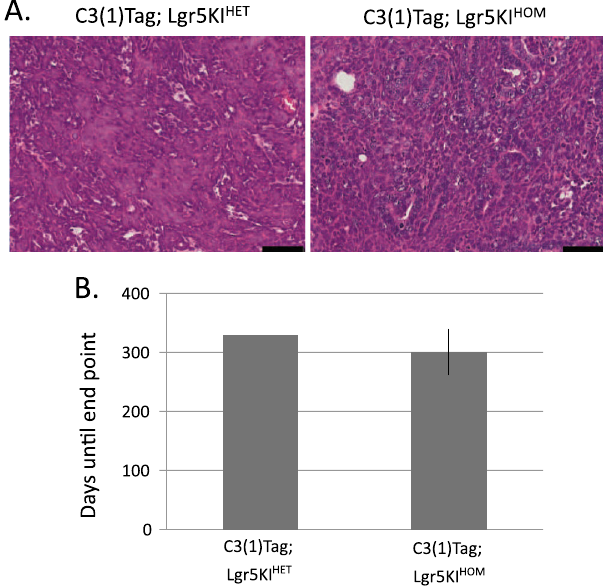
Fig. 6 Lgr5 function is not required for mammary tumorigenesis. Four thousand EpCAM HIGH ; CD49f HIGH ; GFP POS cells were harvested from Lgr5KI HET and Lgr5KI HOM ; C3(1)Tag mice at E18 and injected into cleared recipient fat pads. Mice were euthanized at end point, which was when tumors reached 1 cm in diameter. a H and E stained sections of tumors harvested from mice transplanted with C3(1)Tag; Lgr5KI HET and C3(1)Tag; Lgr5KI HOM fMaSCs. Bar represents 50 µM. b Time to endpoint (tumors with a diameter of 1 cm) was compared between glands that were transplanted with Lgr5KI HOM or Lgr5KI HET ; C3(1)Tag fMaSCs. Two mice reached end point due to Lgr5KI HET C3 (1)Tag fMaSCs, both at 329 days. Three mice reached end point due to Lgr5KI HOM C3(1)Tag fMaSCs, at an average of 300 days (+/ − 45